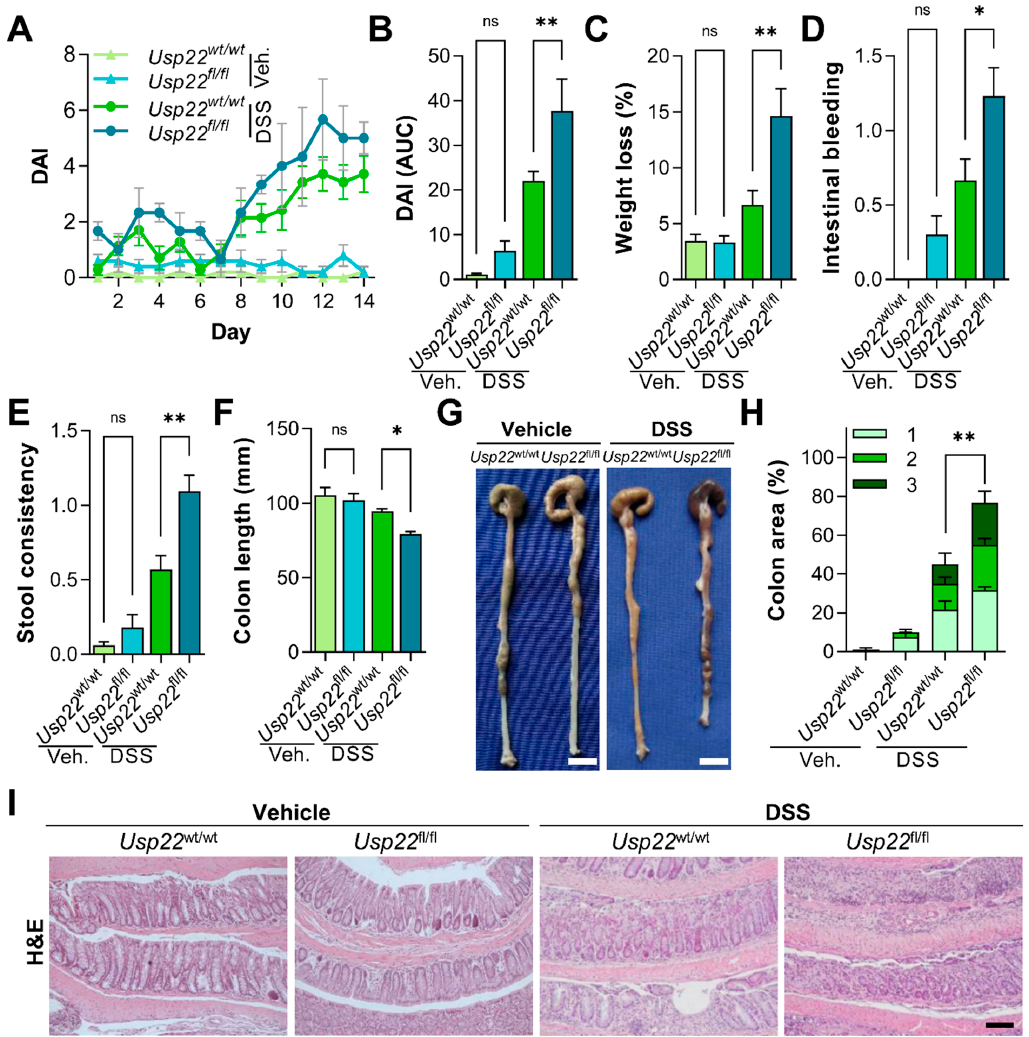
Figure 1. The intestinal deletion of ubiquitin-specific protease 22 ( Usp22) exacerbates dextran sodium sulfate (DSS)-mediated colitis. ( A ) Villin-CreER T2 , Usp22 flox mice were treated with 0.75% DSS or H 2 O alone (vehicle) for 14 days and sacrificed on day 15. The disease activity index (DAI) was determined daily and the ( B ) area under the curve was calculated. (C-F) The increased DAI was mediated by elevated weight loss ( C ), the presence of occult blood ( D ) and diarrhea ( E ) in DSS- treated Usp22 fl/fl mice. ( F ) The colon length of Usp22 knockout animals during acute colitis was reduced. ( G ) Representative images of colons. Scale bar: 1 cm. ( H ) H&E-stained colon sections were analyzed and the percentage of epithelium dis- playing mild (1), moderate (2) and severe (3) damage was determined. Usp22 deletion exacerbated colitis-associated tissue damage. Statistical analyses are based on the H-score. ( I ) Representative images of H&E-stained colon sections. Scale bar: 100 μ m. Mean ± SEM. One-way ANOVA. * p ≤ 0.05, ** p ≤ 0.01.